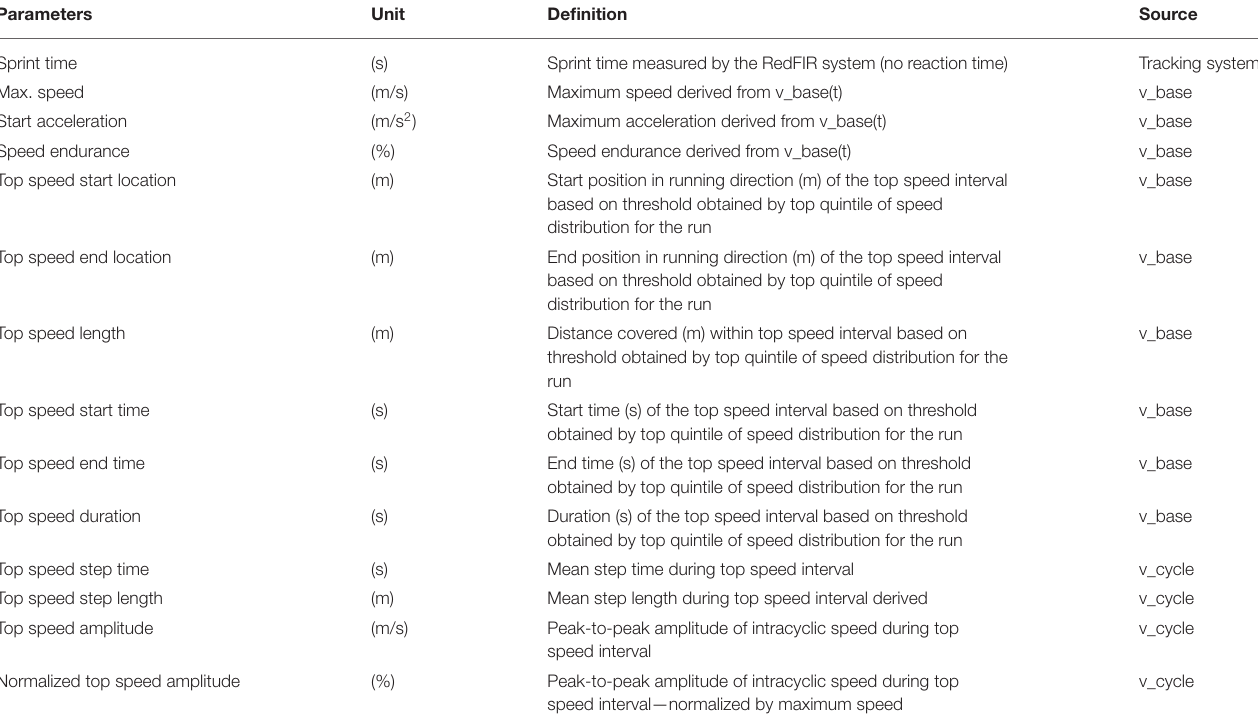
TABLE 1 | Overview for automatically derived parameters.